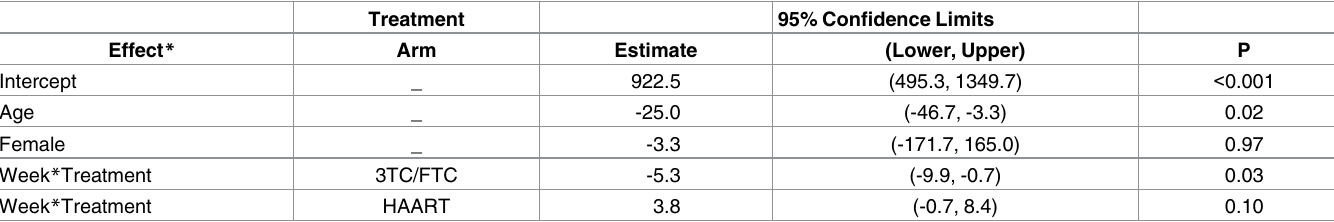
Table 2. Random effectsmixed model for CD4